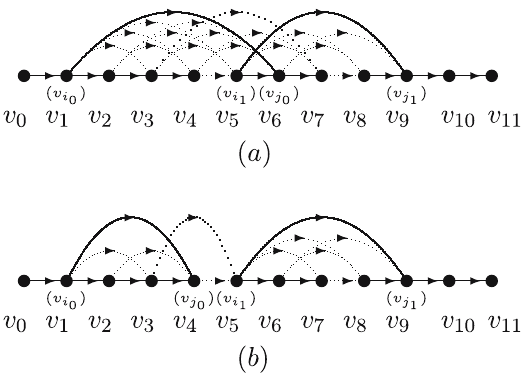
Figure 3: ( a ) An example for Case 1 in Lemma 2.2, where there is no invalid cross arc; ( b ) an example for Case 2 in Lemma 2.2, where there is an invalid cross arc v v 3 5